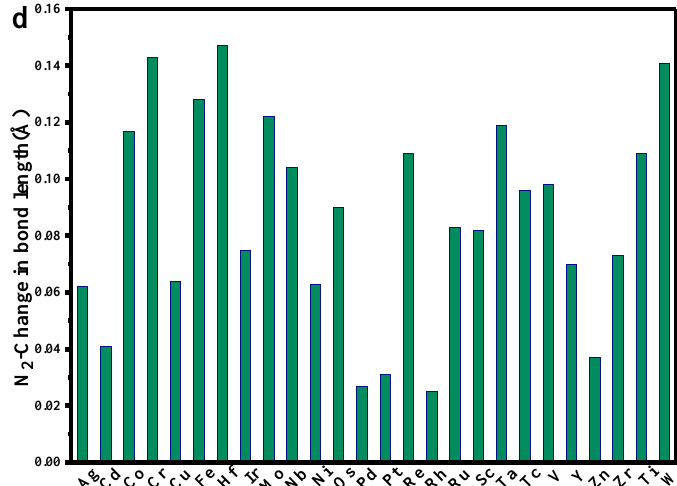
Figure 1. ( a ) Prototype of two-dimensional M 2 -N 6 @ graphene; ( b ) Comparison of the adsorption energy of N 2 on different metal catalyst candidates; ( c ) Adsorption of different metal catalyst candidates; the charge of the last two N atoms changes. ( d ) On different metal catalyst candidates, comparison of bond length variations.